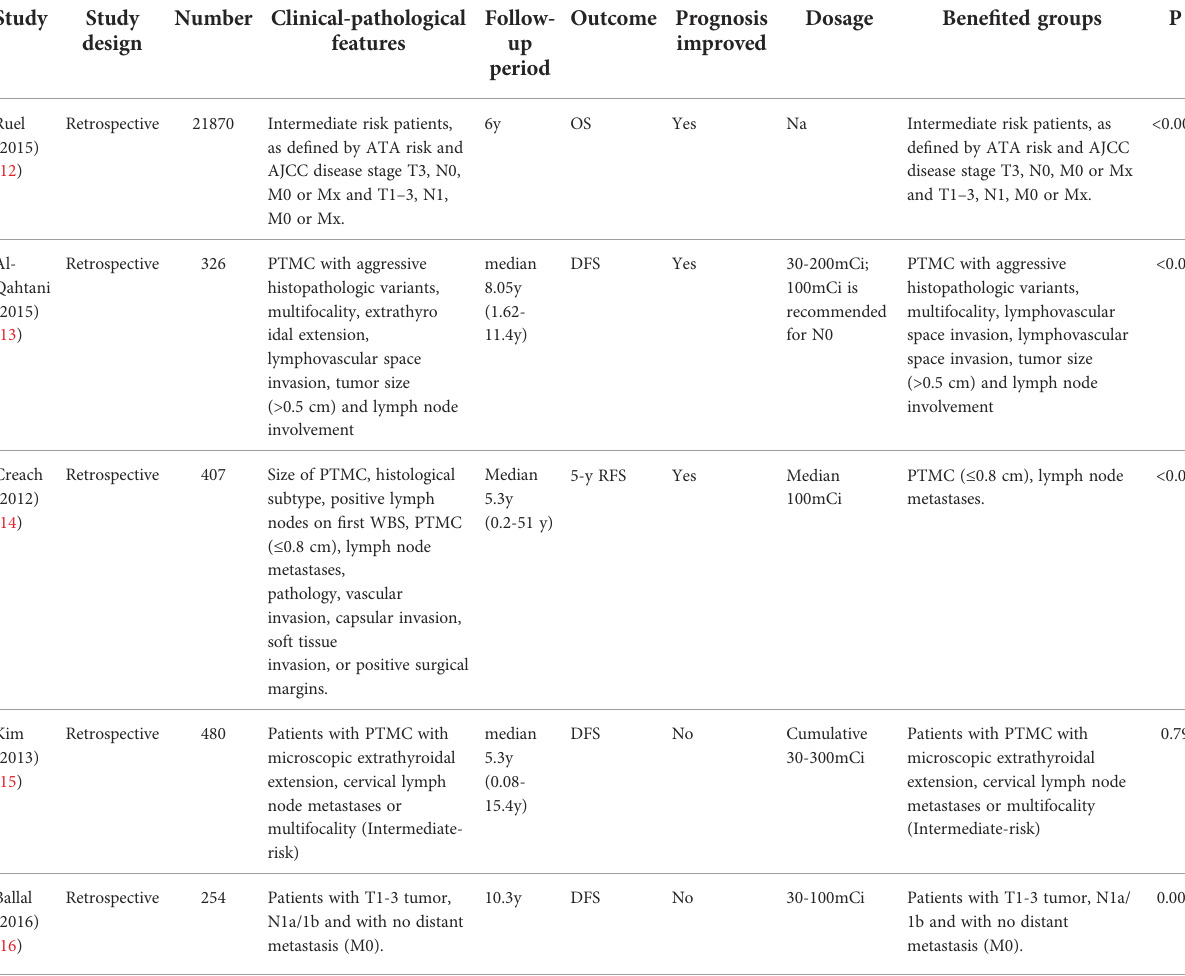
TABLE 1 Clinical outcomes of different clinicopathological features guided RAT.